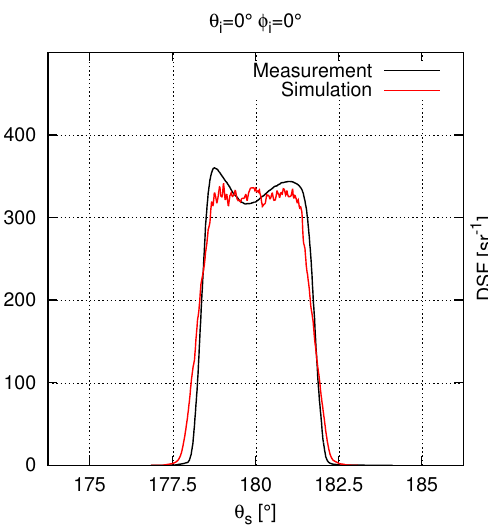
Figure 7. Comparison of the illumination systems for measurement and simulation at θ i = 0 ◦